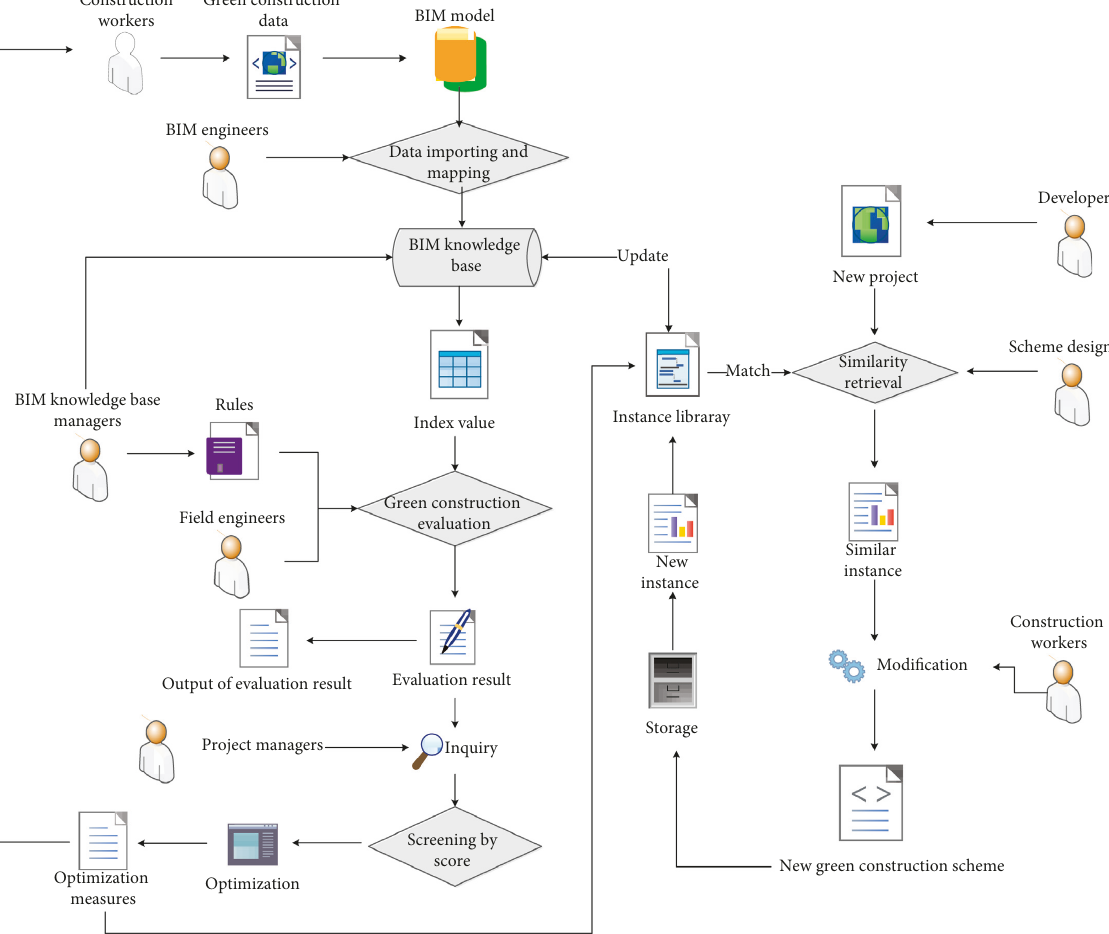
Figure 14: Flow chart of BIM knowledge base